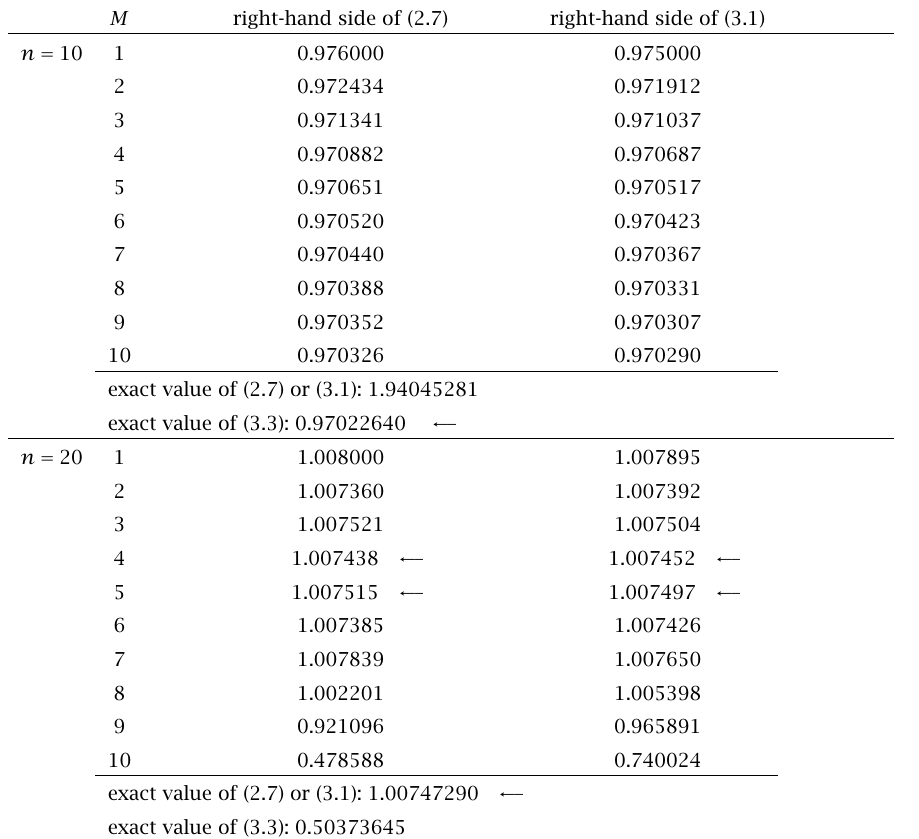
Table 3.1 . Values of the right-hand sides of (2.7) and (3.1) for the parameters a = − 11 . 7, b = − 11 . 2, c = − 11 .